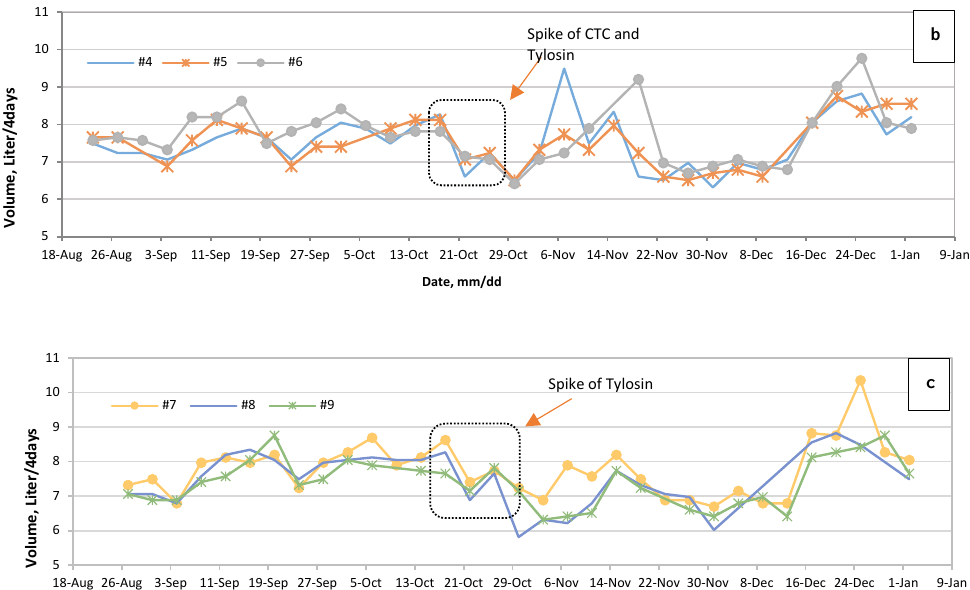
Figure 2. Biogas production in 2017–2018, ( a ) #1 low, #2 medium and #3 high concentration, before and after adding CTC, ( b ) #4 low, #5 medium and #6 high concentration, before and after adding both CTC and tylosin, and ( c ) #7 w, #8 medium and #9 high concentration, before and after adding tylosin and the dotted box shows the administration period of the VAs.